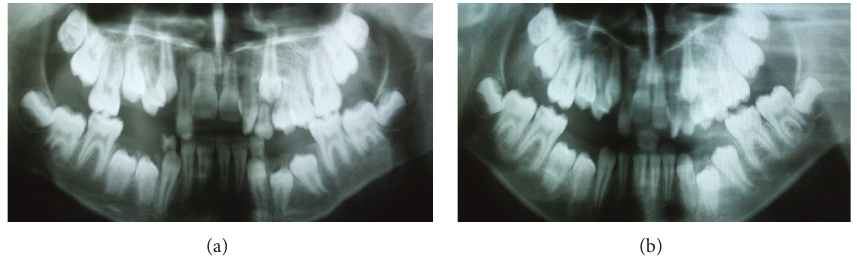
Figure 5: (a, b) Six-month and 12-month follow-up radiographs.